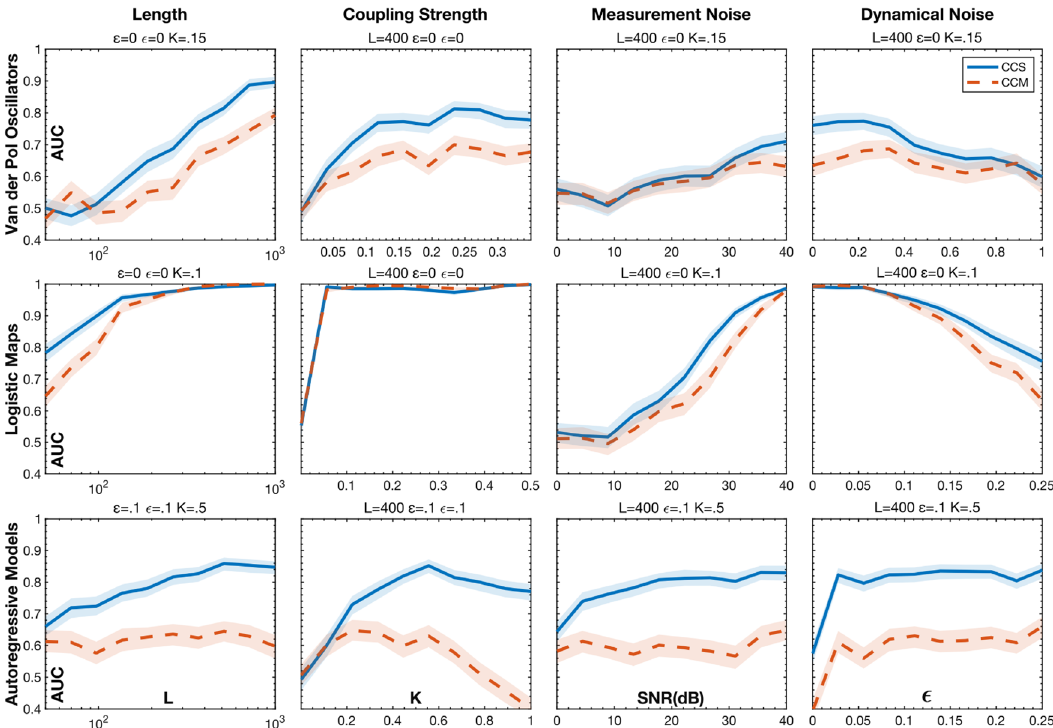
Figure 2. The ROC AUC of CCS and CCM for detecting causal coupling in networks of three variables as a function of signal type, time series length, coupling strength, measurement noise, and dynamical noise. For each condition, the area under the curve (AUC) was calculated using 200 trials of three variable networks. (See Supplementary Area Under the Curve 3 Variable for more information on the accuracy quantification and Table S1 and Choice of Embedding Parameters for detailed methods) The shaded boundaries represent the 95% confidence intervals of the AUCs. For an additional comparison with Granger Causality see Supplementary Fig